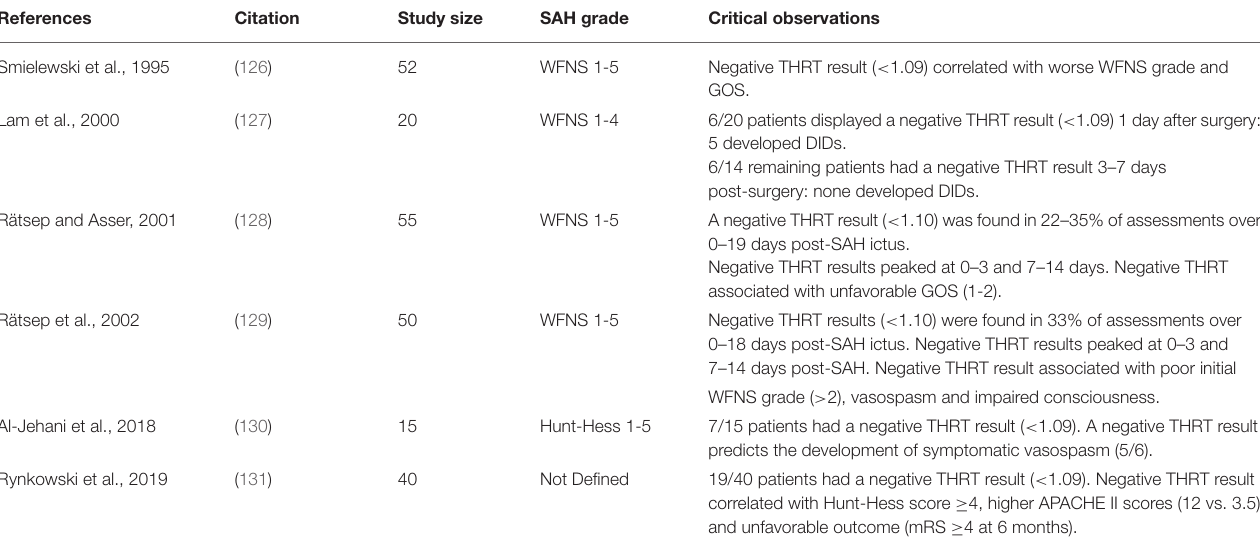
TABLE 3 | Clinical studies utilizing the Transient Hyperemic Response Test (THRT) in subarachnoid hemorrhage patients.